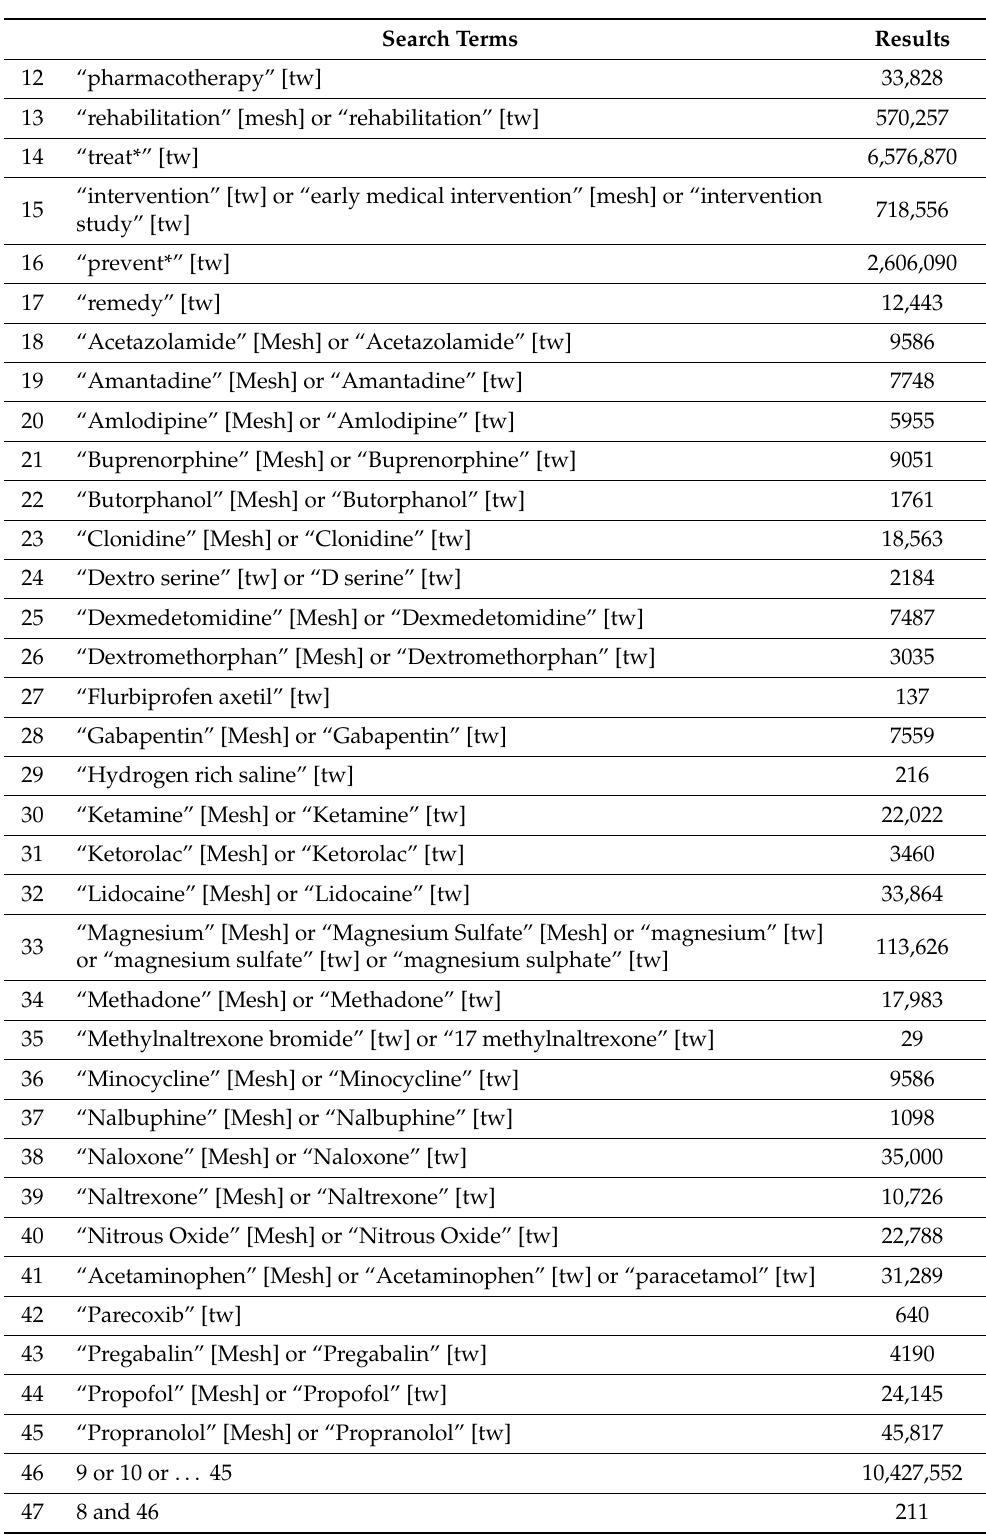
Table A5. PubMed search strategy development. The number of records retrieved for search items in